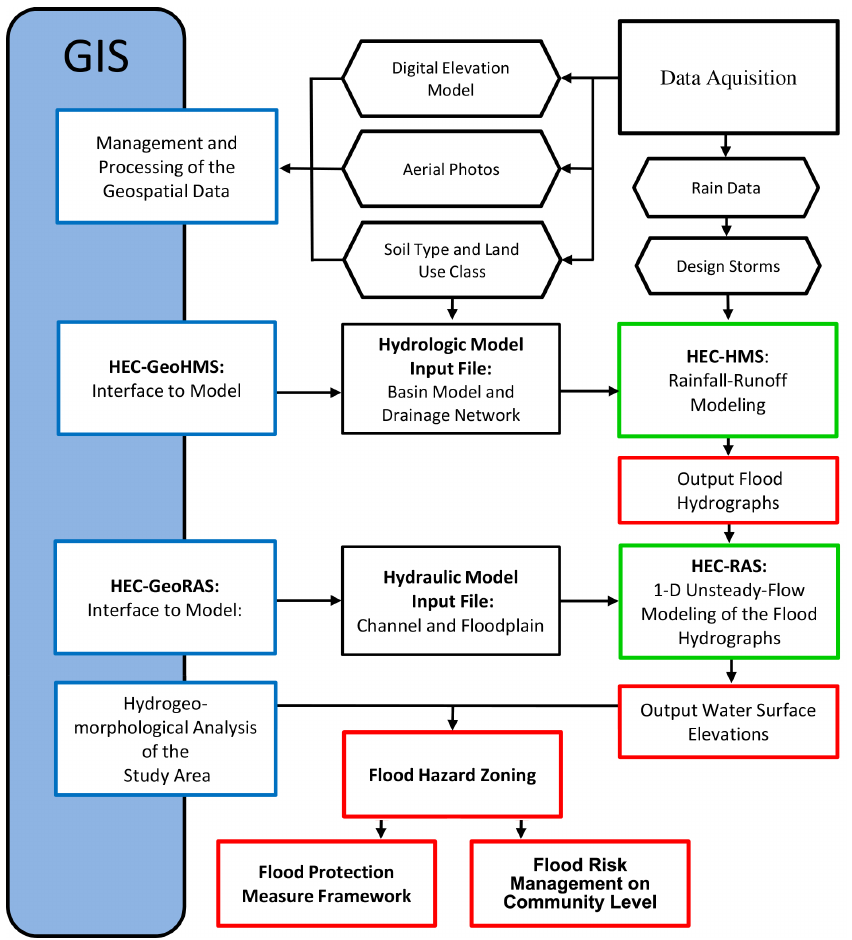
Figure 8. Flowchart of the GIS-based hydrologic and hydraulic modeling framework and flood risk